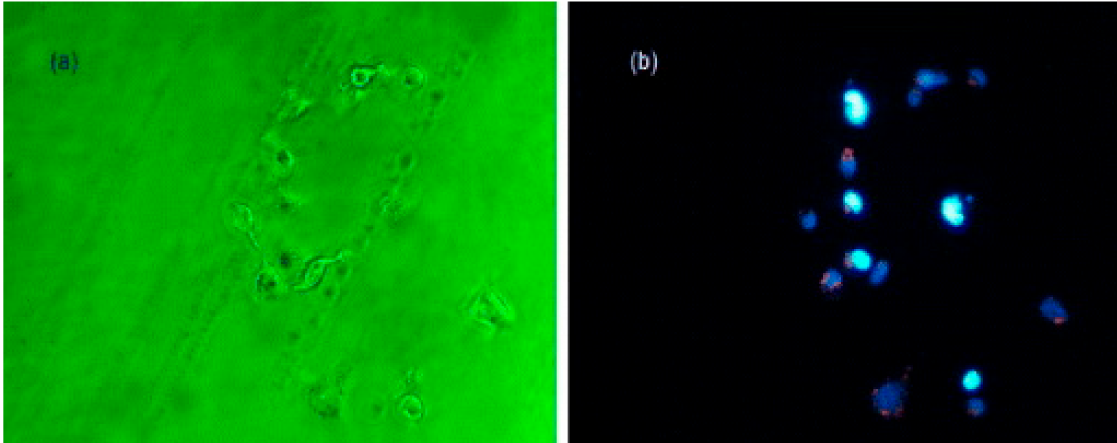
Figure 8. Quantum dot-containing zein nanoparticles were able to internalize and emit fluorescence useful for imaging as seen from a fluorescent ( a ) and confocal image ( b ). Reprinted with permission from ref. [69]. Copyright 2012 IOP Science.